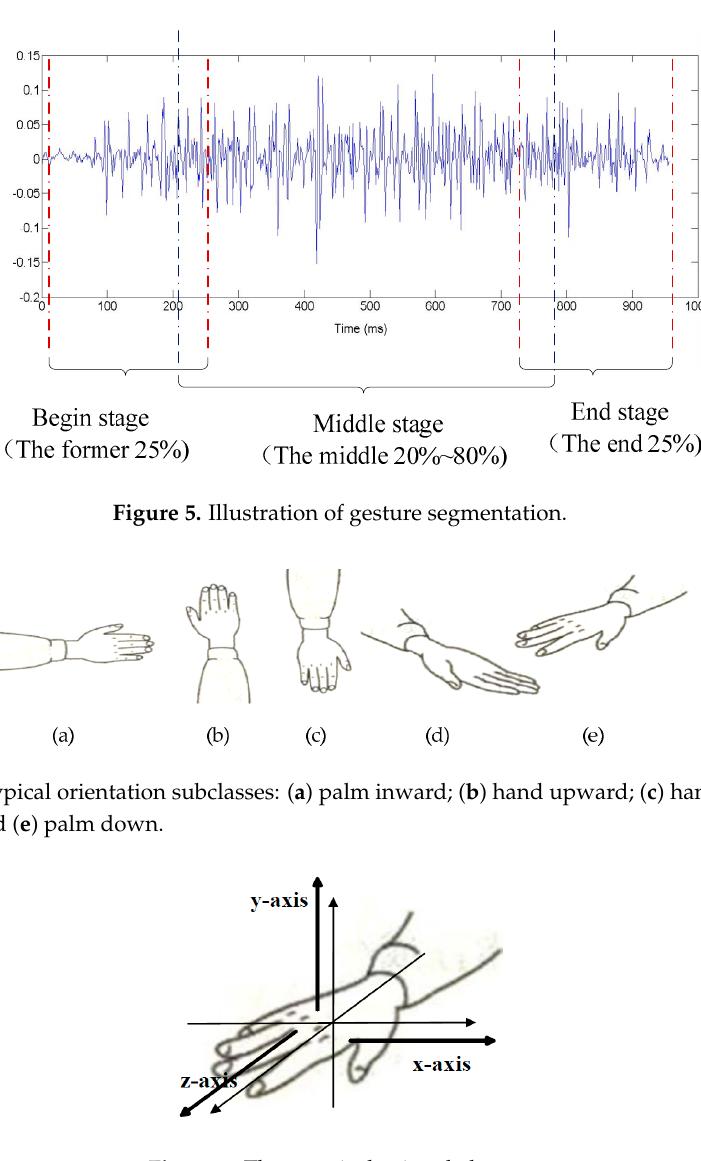
Figure 7. Three typical axis subclasses.